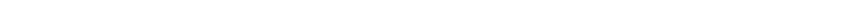
Table 1. Activities that took a year or more longer than suggested in the WHO GLP Handbook. Excess duration includes extended periods of inactivity, e.g. between identifying/booking training and training taking place and does not represent continuous